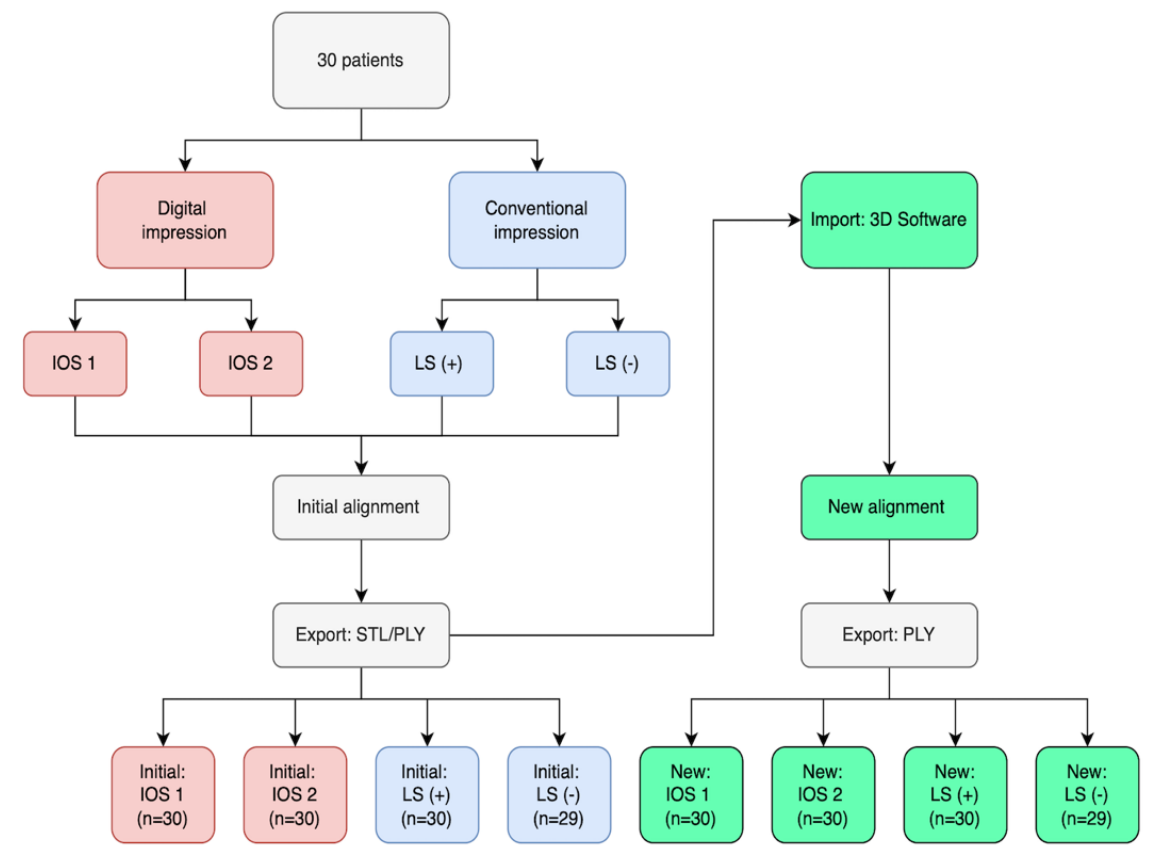
Figure 1. Flow diagram of initially (red, blue) and newly (green) aligned scans.